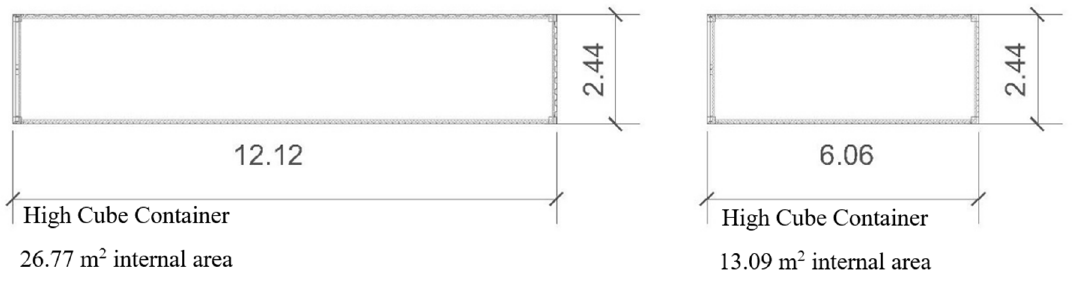
Figure 5. Site plan of the Mosul relocatable hospital in the city of Mosul. Case study.